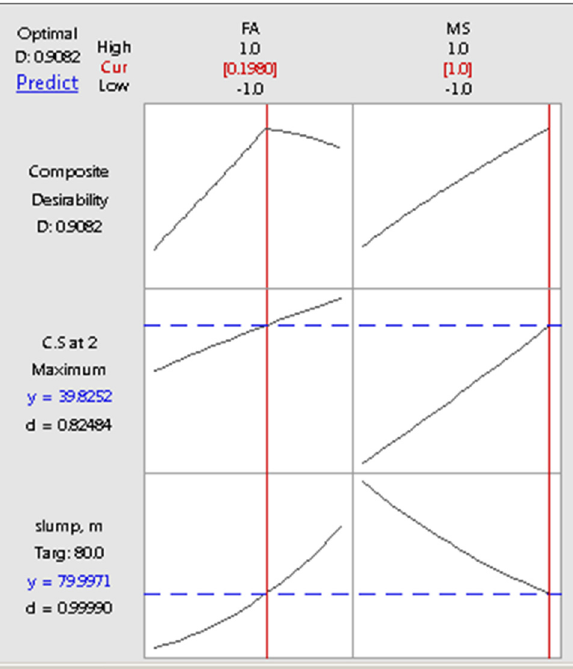
Figure 8: Optimization plots for 80 mm slump and maximum CS at 28